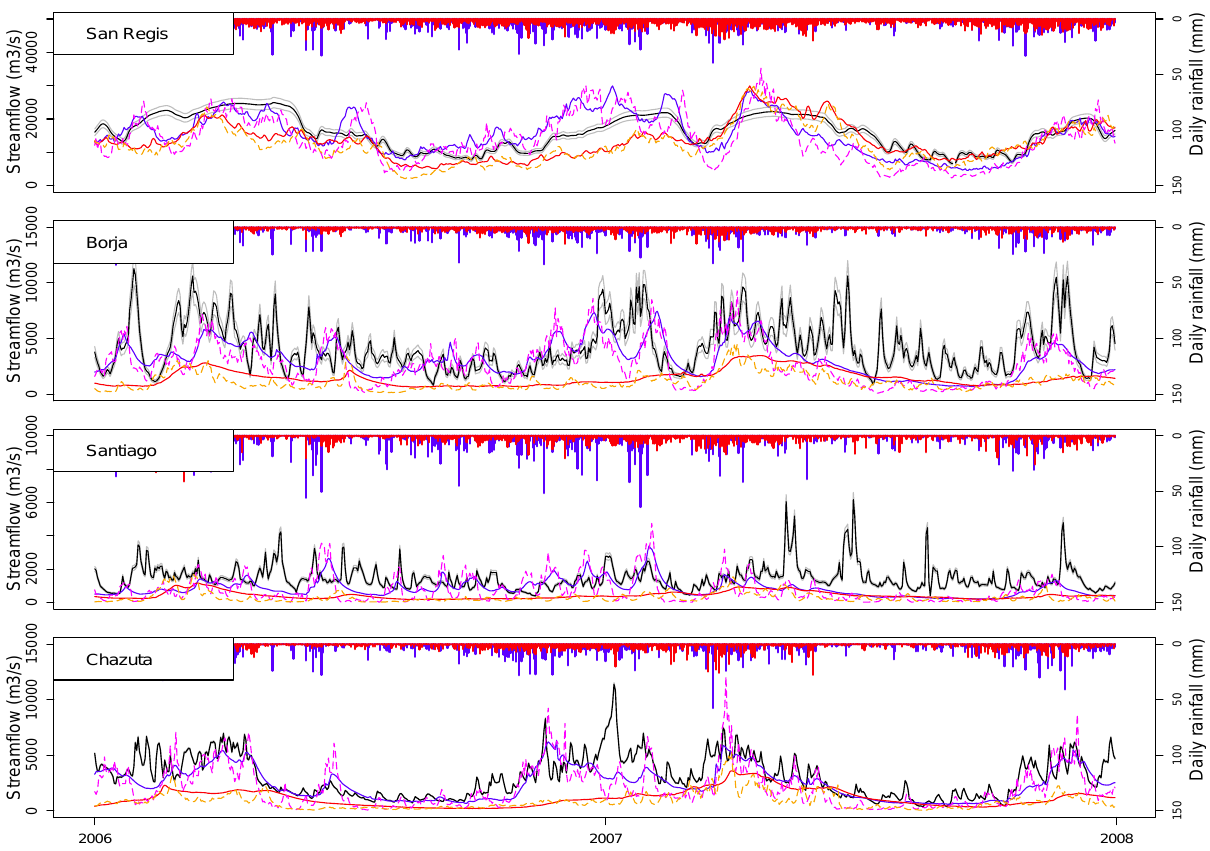
Fig. 5. Modelled versus measured streamflows at all four gauging points for the modelling period 2006–2007. The overlying barplots are the basin-average precipitation time series. Black: observed flow, gray: 95% confidence interval, blue: JULES-BASE and TRMM, magenta: JULES-TOPMODEL and TRMM, red: JULES-BASE and NCEP, orange: JULES-TOPMODEL and NCEP.